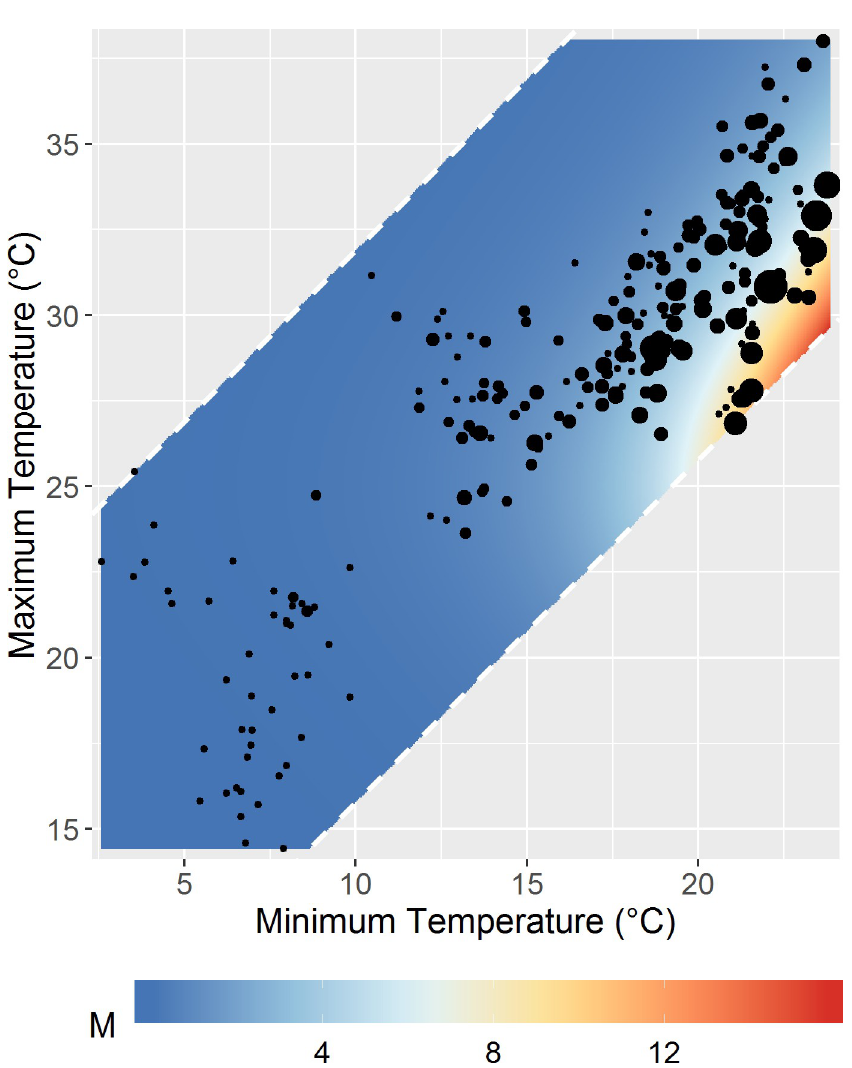
Fig 5. Predicted counts of Ae . albopictus abundance as a smoothed function of minimum and maximum daily temperatures summarized over the preceding week. Black dots represent observed mosquito abundance with the size of the dot proportional to the number of